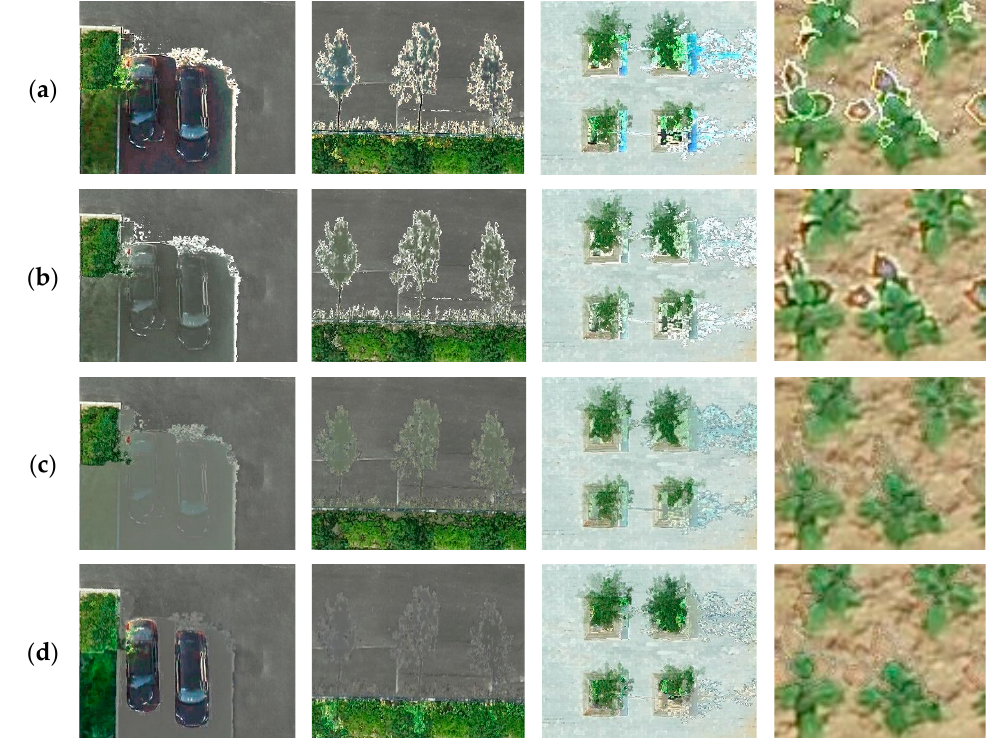
Figure 8. Local enlargement of the compensation results of different methods applied to the four study cases: ( a ) illumination correction; ( b ) color transfer; ( c ) shadow synthesis; ( d ) the proposed method.